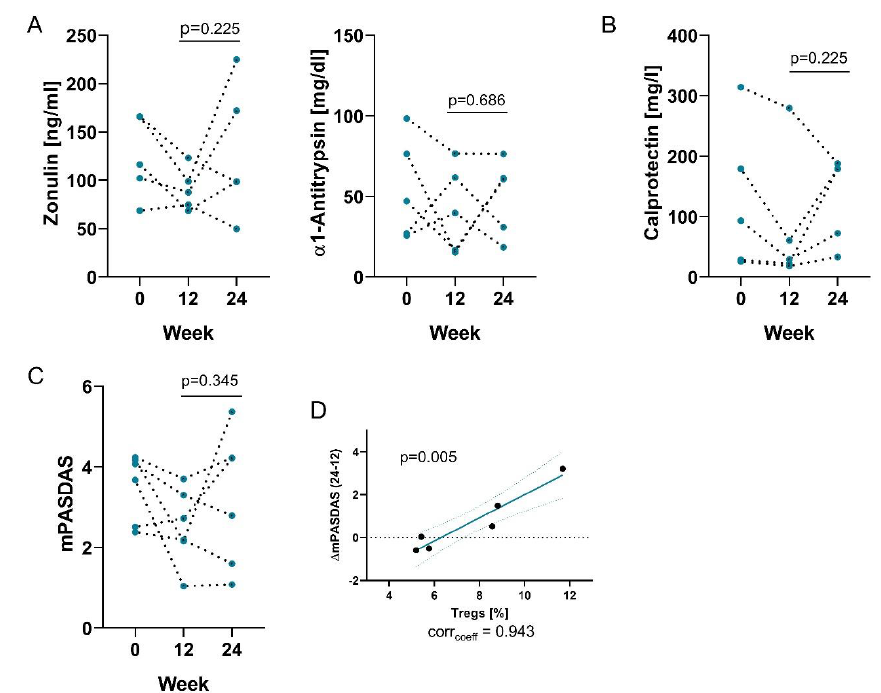
Figure 4. Effects of probiotics are not long-lasting. Graphs show ( A ) fecal concentrations of zonulin (left) and α1-antitrypsin (right); ( B ) fecal concentrations of calprotectin; ( C ) mPASDAS score at baseline, week 12 and 24 following the termination of probiotics treatment; ( D ) Correlations of the change of PASDAS from week 12 to 24 with the frequency of Tregs.